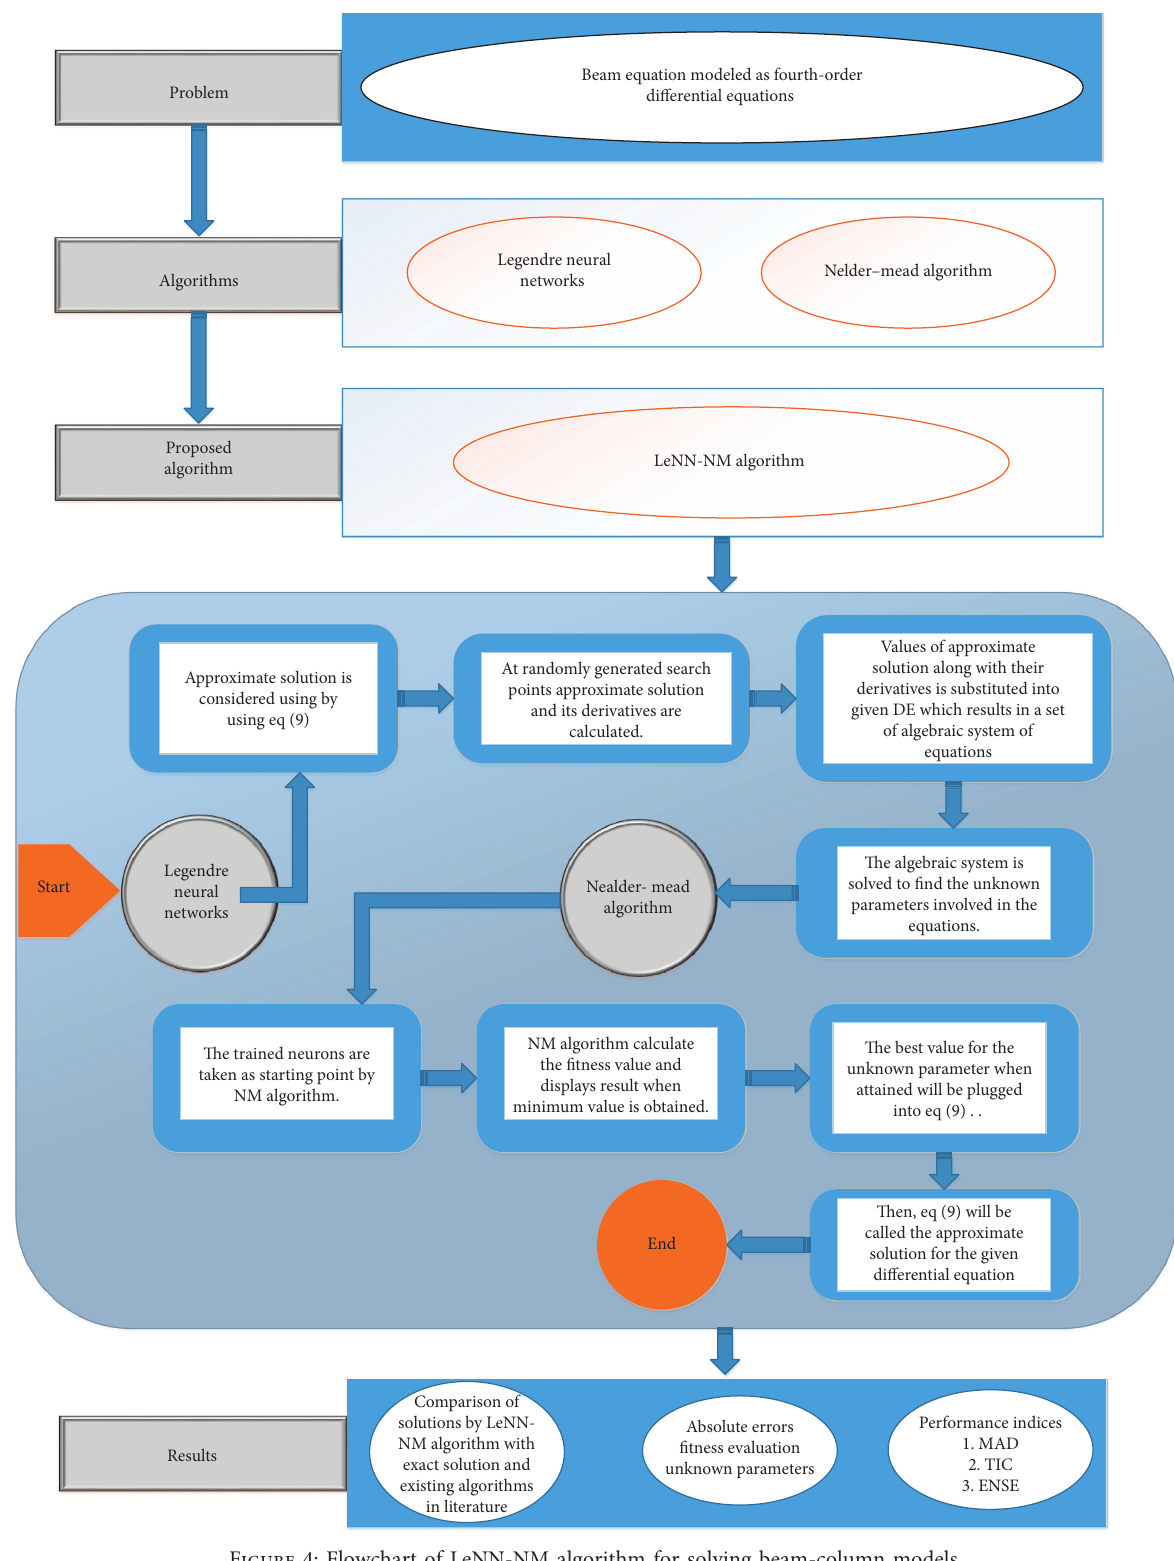
Figure 4: Flowchart of LeNN-NM algorithm for solving beam-column